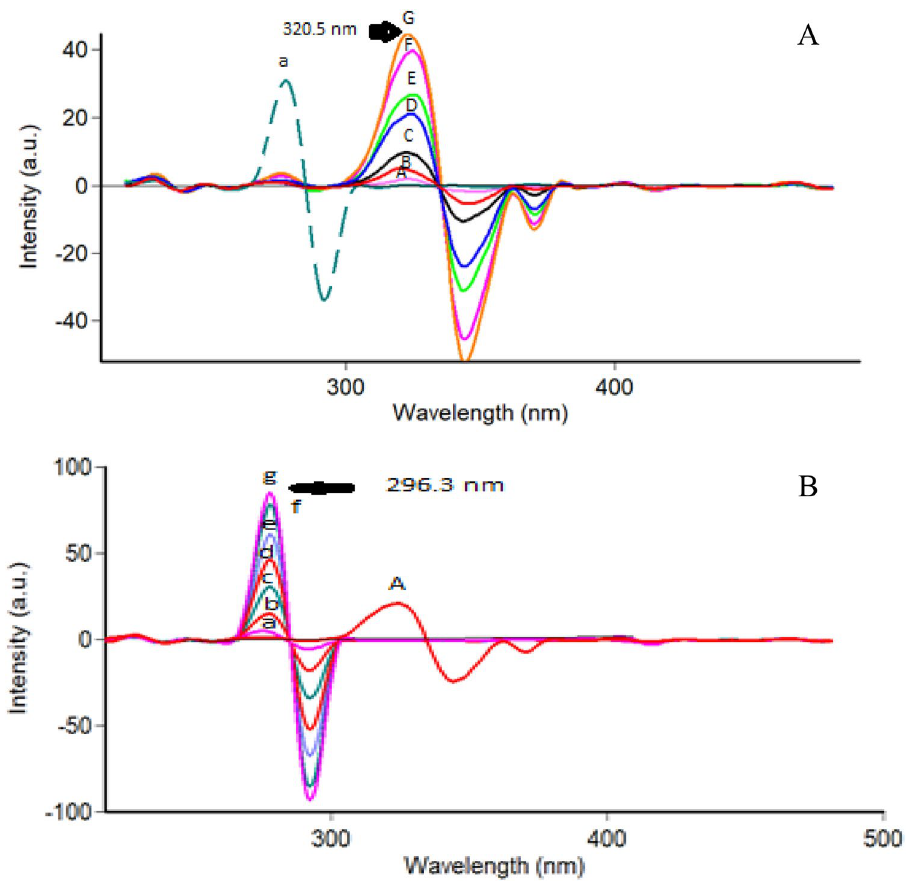
Figure 5. ( A ): First derivative synchronous fluorescence spectra of various concentrations of TEL with a constant concentration of NEB. Where: (A -F): TEL at concentrations of (50.0, 100.0, 200.0, 400.0, 500.0, 700.0 and 800.0 ng /mL). (a): NEB concentration (200.0 ng /mL). ( B ): First derivative synchronous fluorescence spectra of various concentrations of NEB with a constant concentration of TEL. Where:(a-f): NEB at concentrations of (30, 100, 200, 300, 400,500 and 550 ng /mL). (A): TEL concentration (400.0 ng /mL).